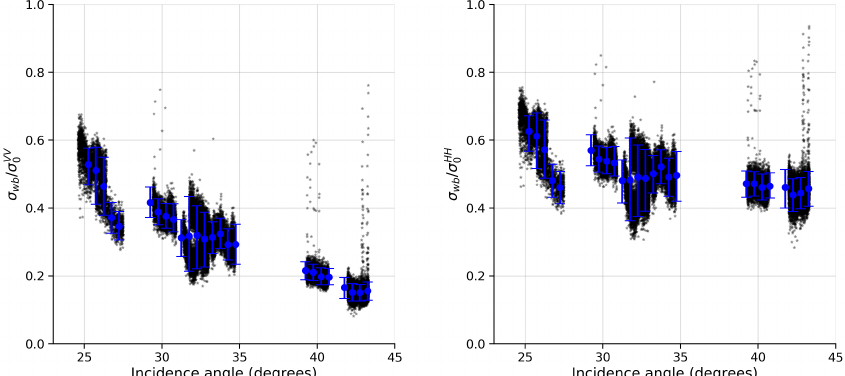
Figure 3. Relative contribution of σ wb in VV ( left ) and HH ( right ) components when using a simplified TSM model. RadarSAT-2 observations are represented as black dots, while red circles with vertical bars are mean values and percentiles of 5% and 95%, respectively.